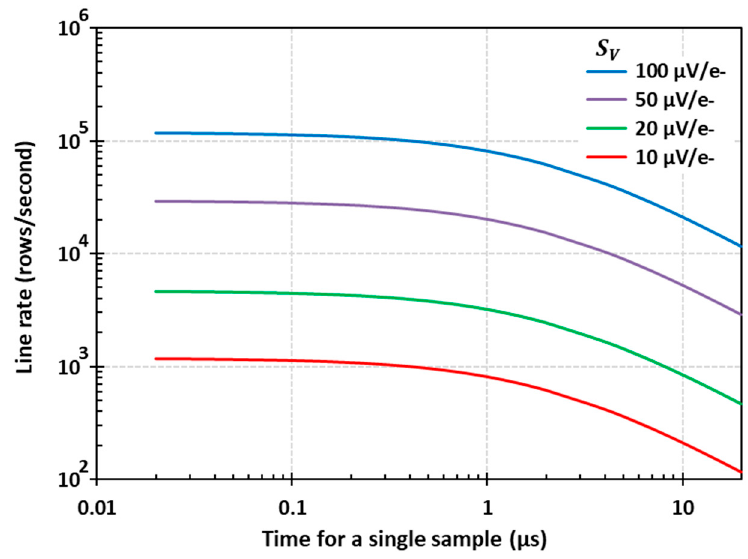
Figure 5. Line rate for 0.15 e- RMS ENC for different conversion gains as a function of the time required for a single sample.